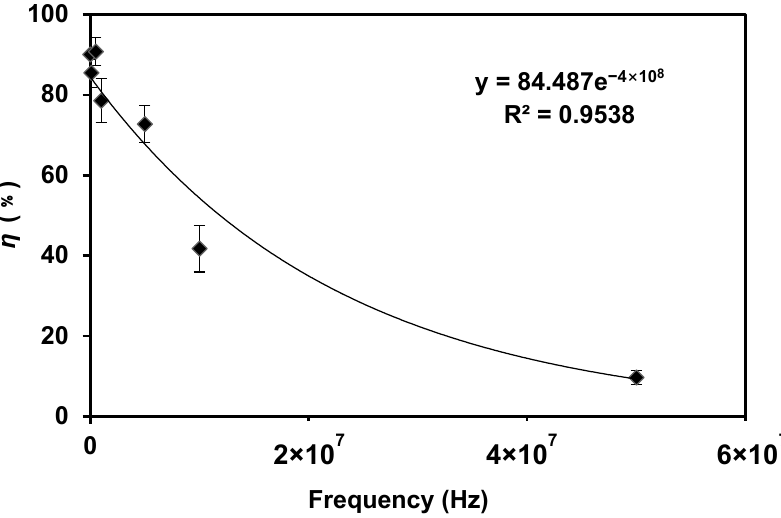
Figure 4. The higher voltage can better break down the bacteria to accelerate the lysis process com- pared with lower voltages. When the voltage was increased, the lysis efficiency was increased. The frequency was kept at 5 MHz and the flow rate was kept at 2 μ L/min.